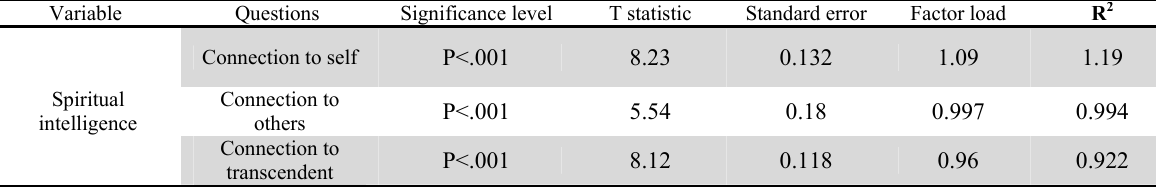
Table 9 indicates the results of CFA on workplace spirituality constituents. As seen. All constituents enjoy acceptable factor load. According to LISREL outcomes, fit indicators of the model show that it is in a favorable situation in terms of fit indicators because that x2/df is 2.25 which is lower than allowed rate (3) and RMSEA is also 0.045 which is lower than allowed rate (0.08). Therefore, it does not need so amendments. P- value is 0.00000 which is lower than